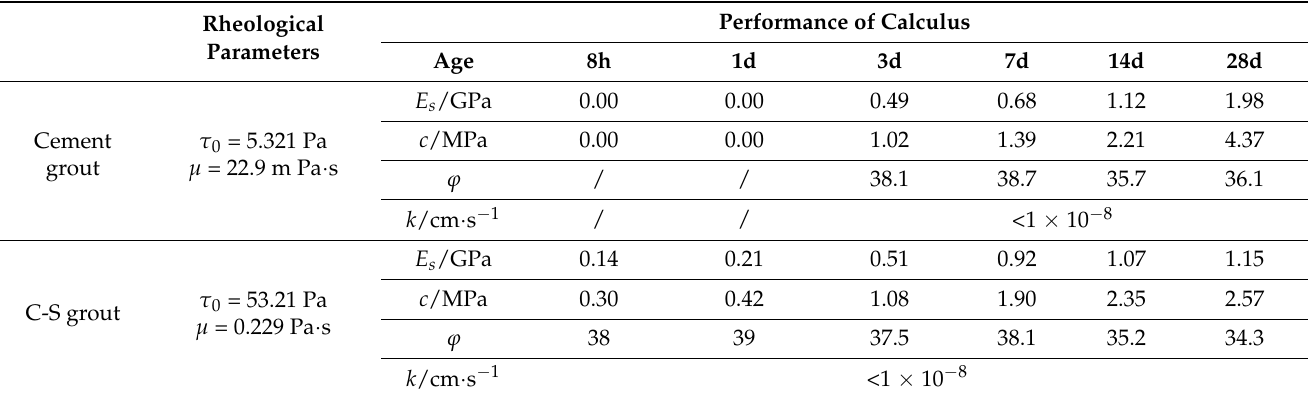
Table 6. Basic performances of cement grout and C–S